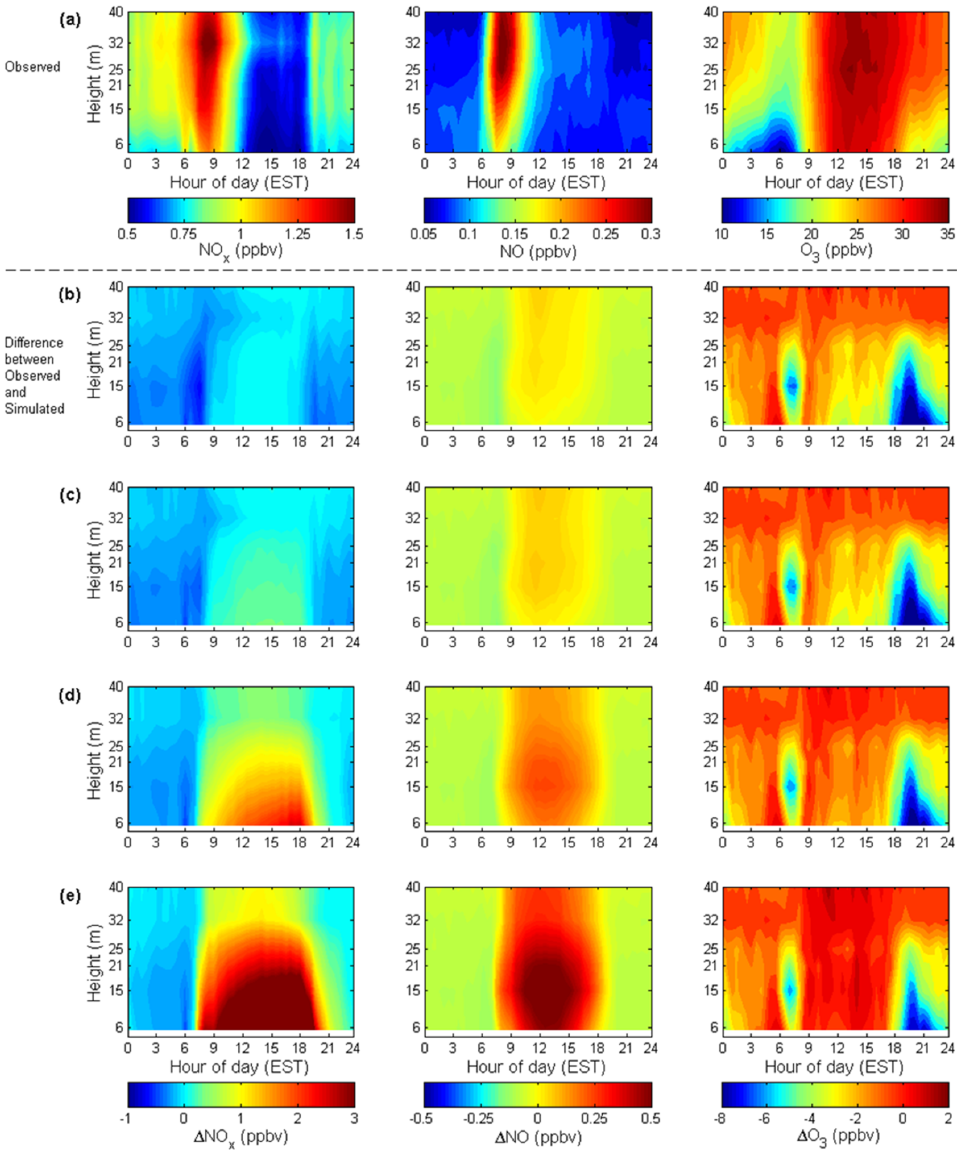
Fig. 10. Similar to Fig. 9 but for sensitivity towards foliage NO x emission. (a) The observed mean diurnal mixing ratio profiles, (b) case for “zero” foliage emission, (c) 1 × case, (d) 10 × case, (e) 25 × case.